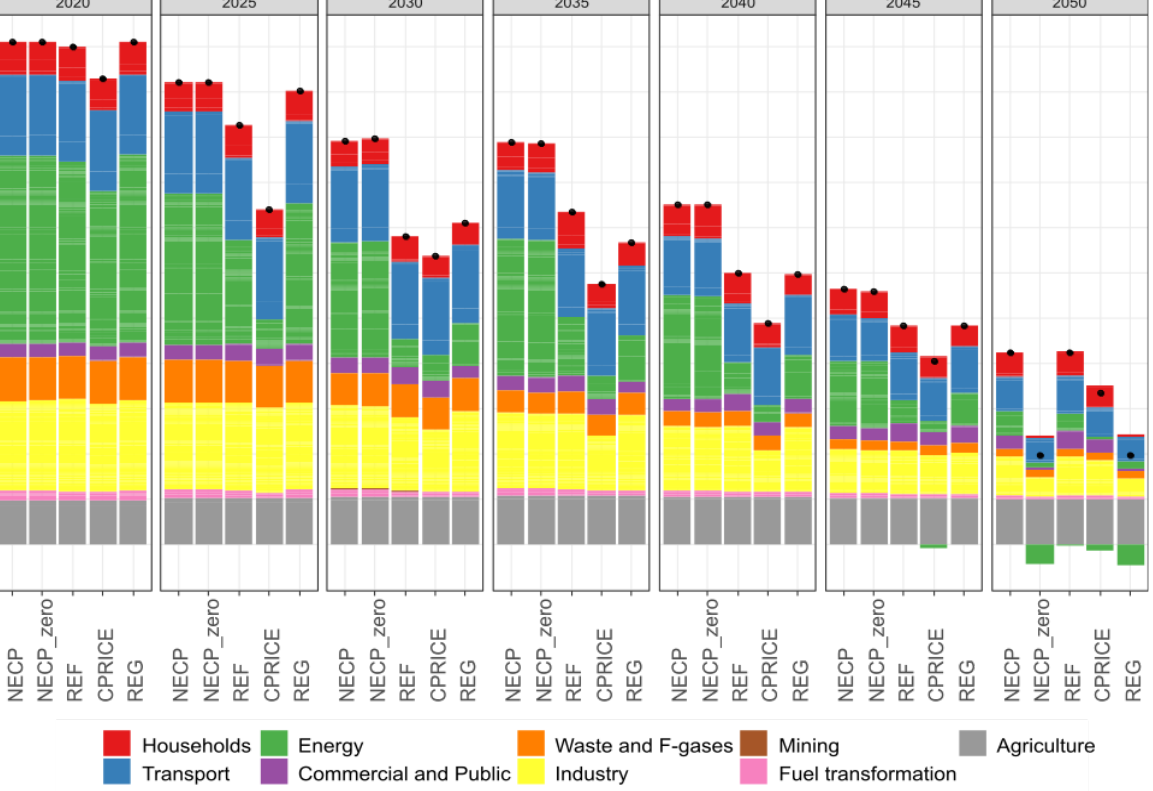
Figure 8. Carbon capture by fuel or industry ( left panel ) and by sector ( right panel ).